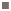
Concentration of RecA and CheW proteins in S. enterica mitomycin-C-treated cells growing in liquid medium.ELISA quantification of RecA (♦, continuous line) and CheW (■, continuous line) proteins of S. enterica ΔcheR cells harboring plasmid pUA1127 (eYFP::cheR) and treated with mitomycin C (0.08 μg/mL). The amounts of RecA (◇, discontinuous line) and CheW (□, discontinuous line) in a non-treated culture are also shown. The concentration is expressed as the number of RecA or CheW molecules per μg of total protein. The results are the mean of three independent experiments. Error bars represent the standard deviation. The relative RecA concentration (boxed) was calculated as the mean RecA concentration at each time point with respect to the mean initial RecA concentration [1.16 (±0.17) x 1011 molecules per μg of total protein].